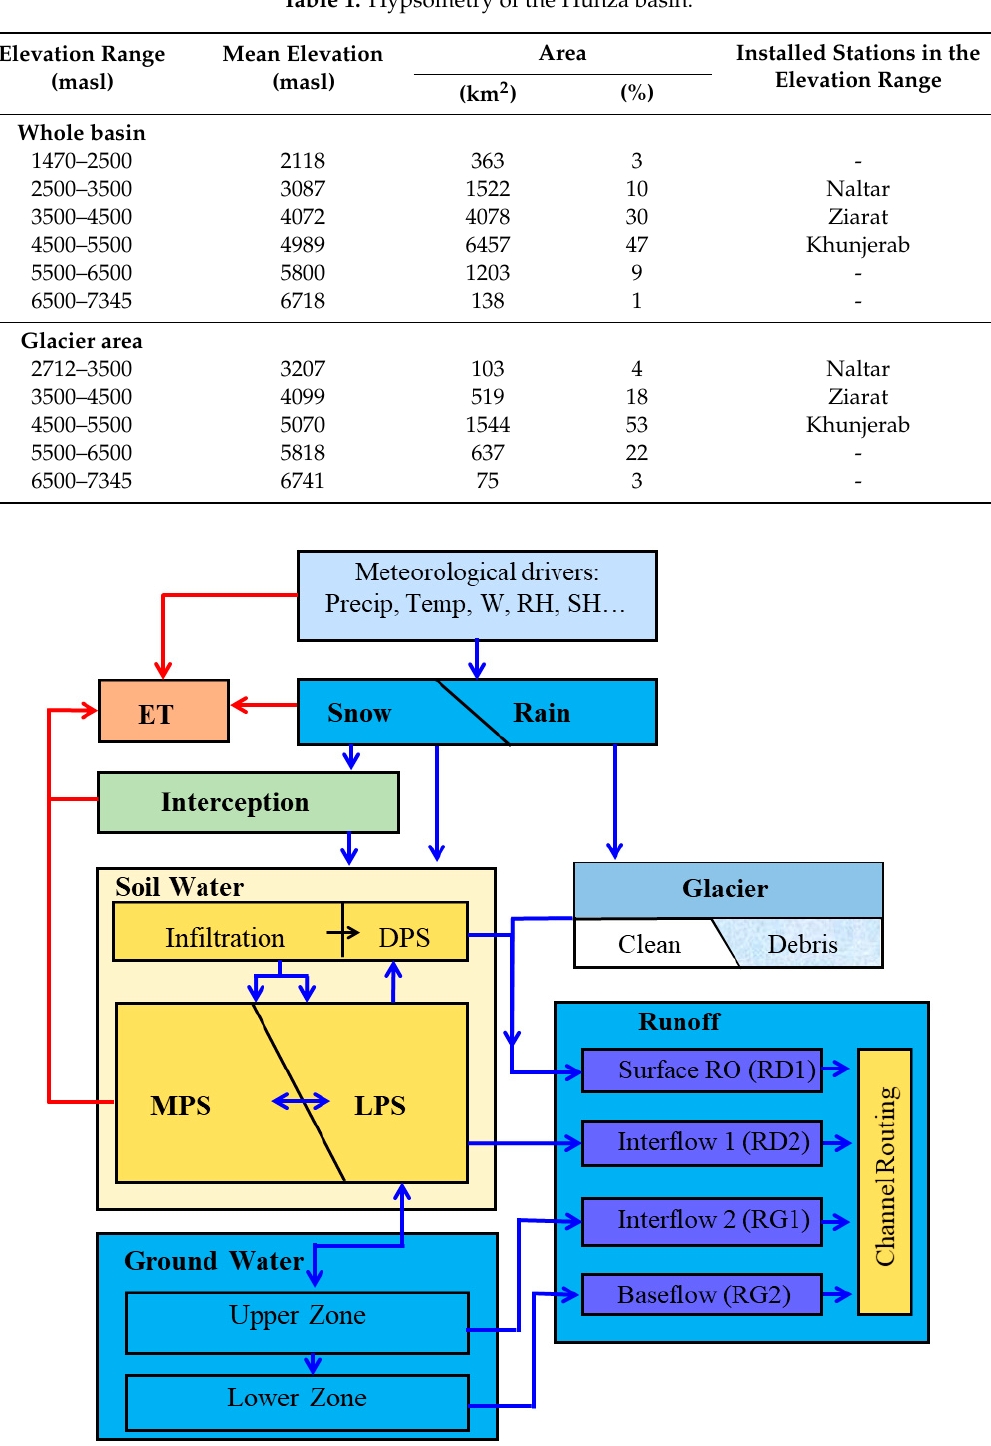
Figure 2. Principal layout of the J2000 model (source: adapted from Krause [40] and Nepal et al. [33]). Note: ET = evapotranspiration, P = precipitation, T = air temperature, W = wind speed, RH = relative humidity, SH = sunshine hours, LPS = large pore storage, MPS = middle pore storage, DPS = depression storage, RO = runoff.